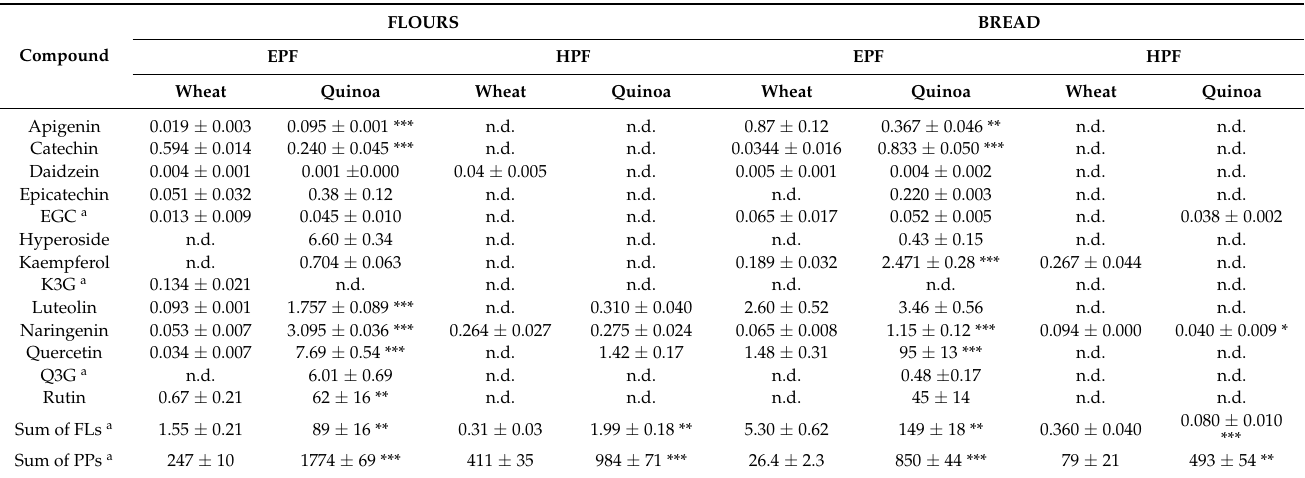
Table 3. Flavonoids quantification ( µ g/g) in raw materials (wheat and quinoa flours) and bread (control and 25% quinoa).